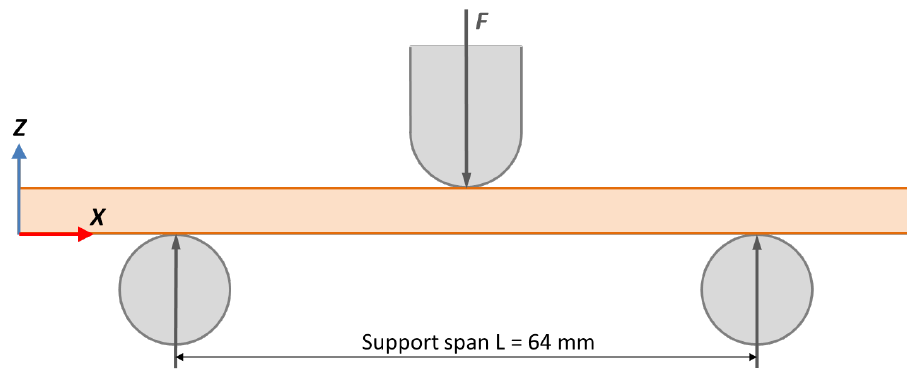
Figure 4. Three-point bending test diagram.